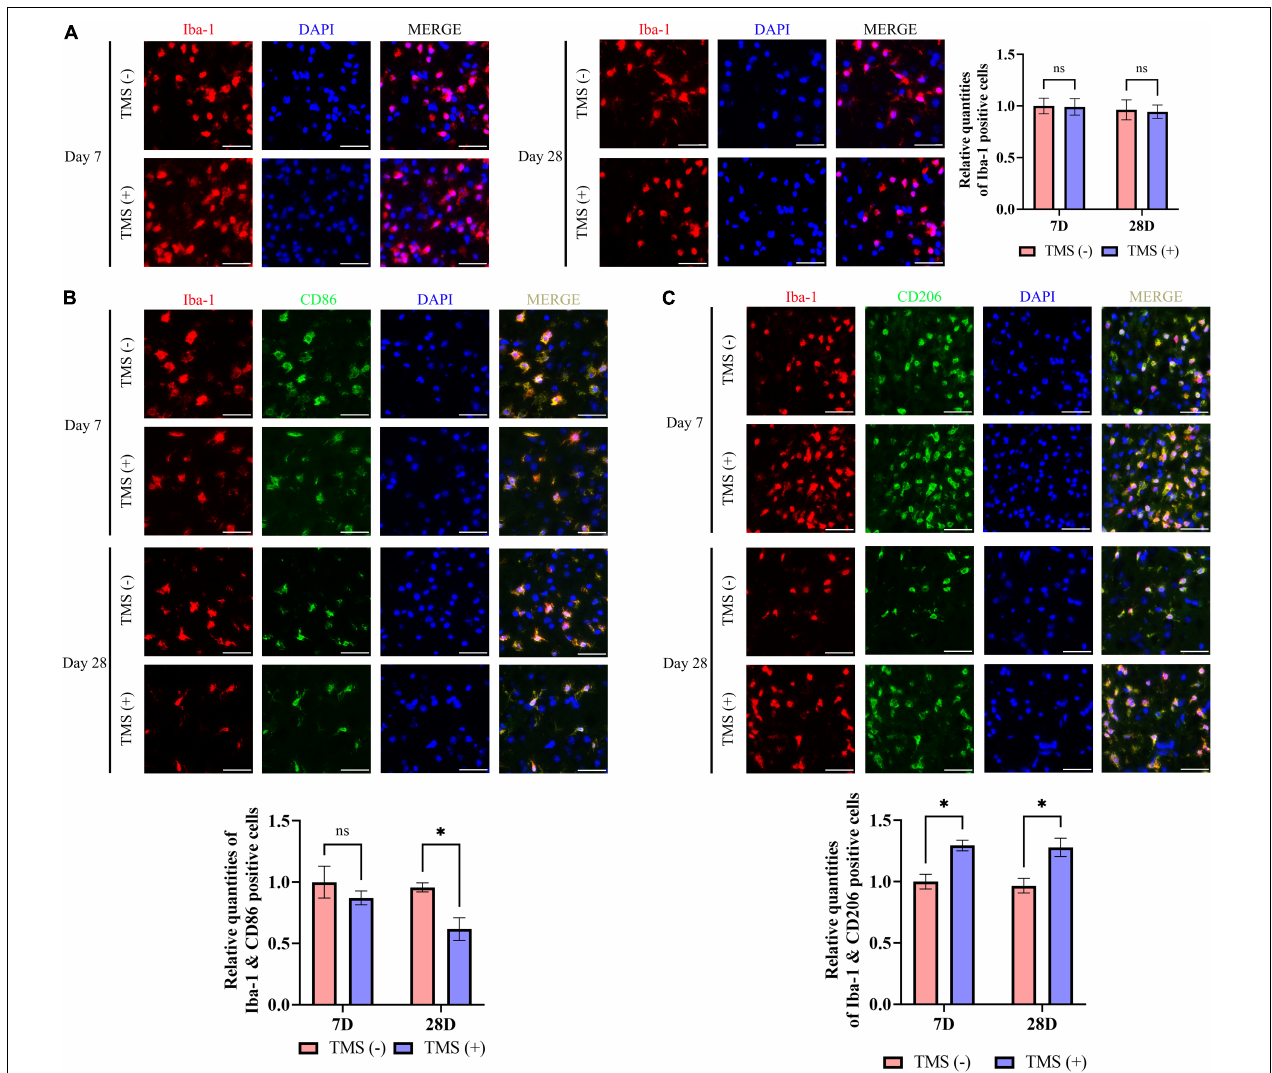
FIGURE 5 | Neuroprotective transformation of microglia in ischemic cerebral cortex. (A) Quantitative analysis of Iba-1 positive microglia in TMS (–) and TMS (+) groups ( n = 3). Quantity of Iba-1 positive cells in TMS (–) group was normalized as control. Iba-1 + and CD86 + neurotoxic (B) and Iba-1 + and CD206 + neuroprotective (C) microglia in TMS (–) and TMS (+) groups ( n = 3). Quantity of Iba-1 + and CD86 + or Iba-1 + and CD206 + cells in TMS (–) group was normalized as control. Data are shown as mean ± SEM. Statistical significance was determined with the unpaired Student’s t -test. Scale bar, 20 µ m, * P < 0.05, and ns means no